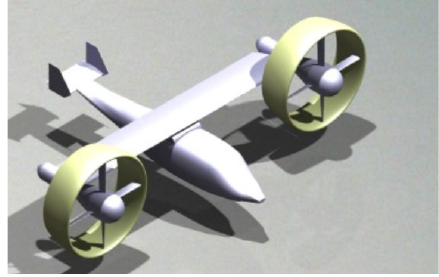
Figure 28. The retrofit equipped with VDDF.